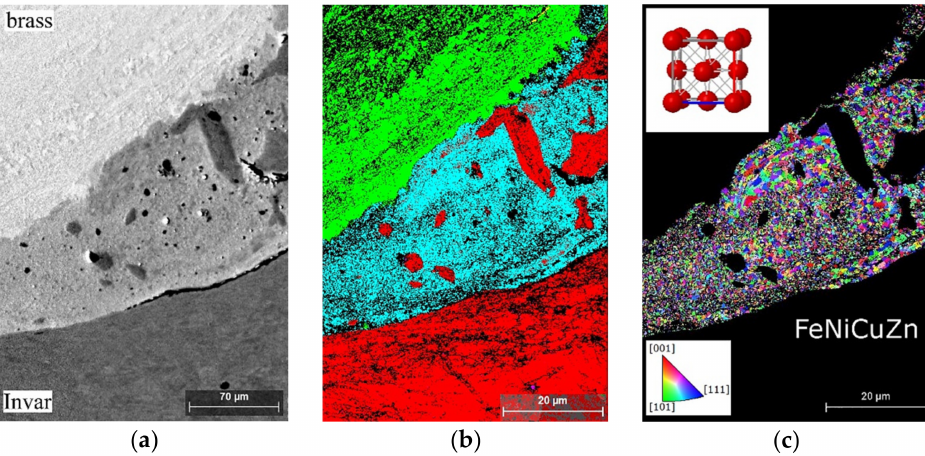
Figure 5. BSD images of brass–Invar weld interface and inverse pole figure (IPF-X) map for Cu–Zn– Fe–Ni: ( a ) image of porous structure of the melted zone; ( b ) phase distribution map of the weld interface, where brass (CuZn) is green, Invar (FeNi) is red and the melted zone (Fe–Ni–Cu–Zn) is cyan; ( c ) IPF-X map of the melted